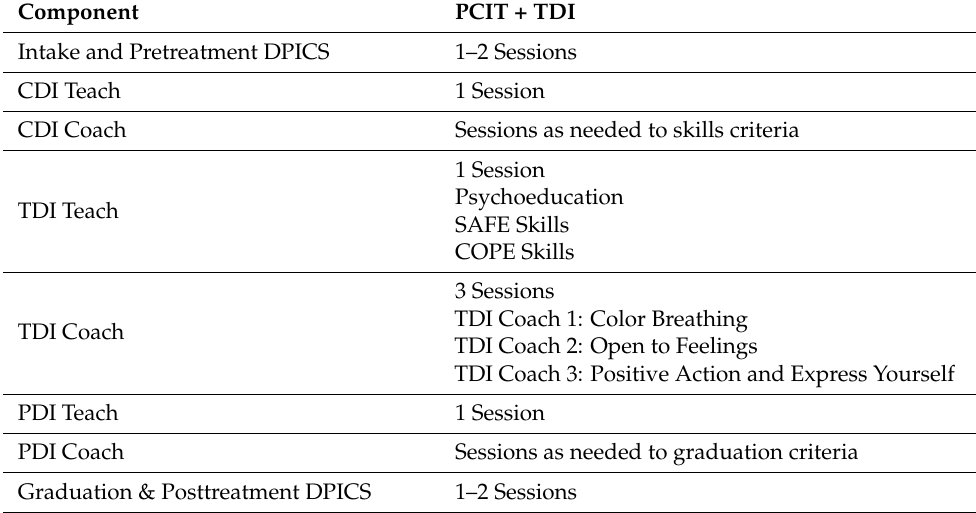
Table 3. TDI session